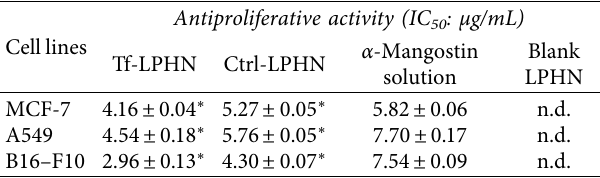
Table 2: Antiproliferative activity of α -mangostin entrapped in Tf- LPHN and Ctrl-LPHN formulations, or free in solution, expressed as IC 50 values, in MCF-7, A549, and B16–F10 cell lines, following 48h treatment (control: blank LPHN) ( n � 4) (n.d.: not deter- mined) ( ∗ p < 0 . 05 vs . α -mangostin